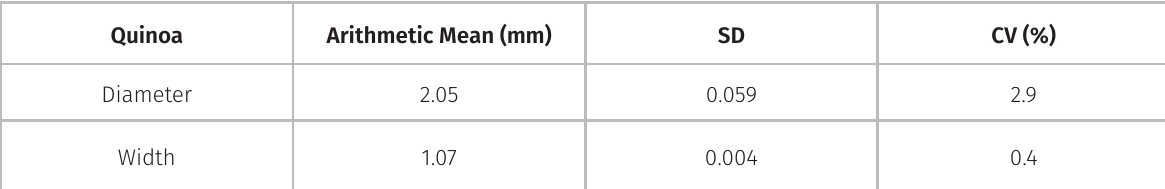
Table I. Arithmetic mean,standard deviation (SD) and coefficient of variation (CV) of the biometric measures of quinoa seeds ( Chenopodium quinoa